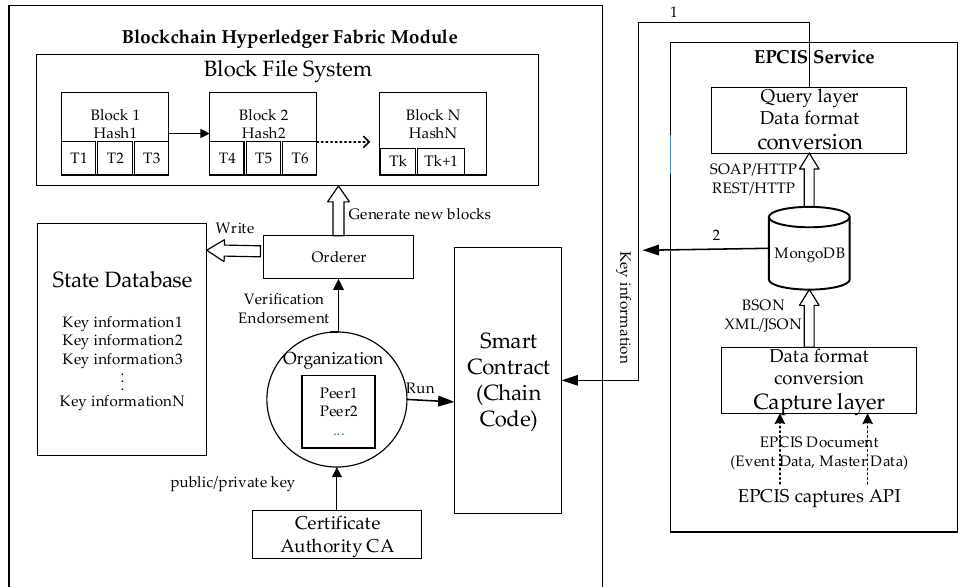
Figure 2. Data interaction between the hyperledger fabric and